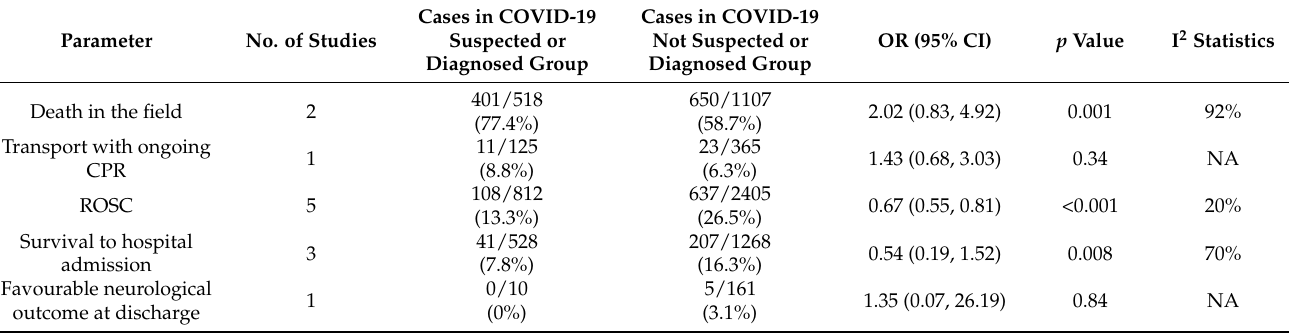
Table 2. Survival outcomes in included